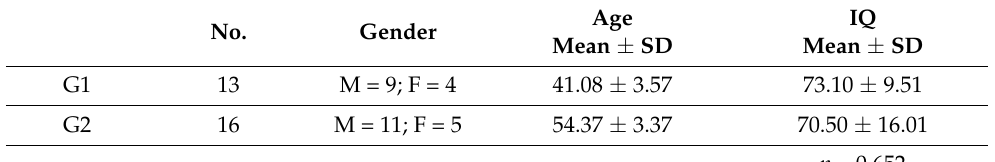
Figure 1. Flowchart with the selection of participants. Table 1. Participants’